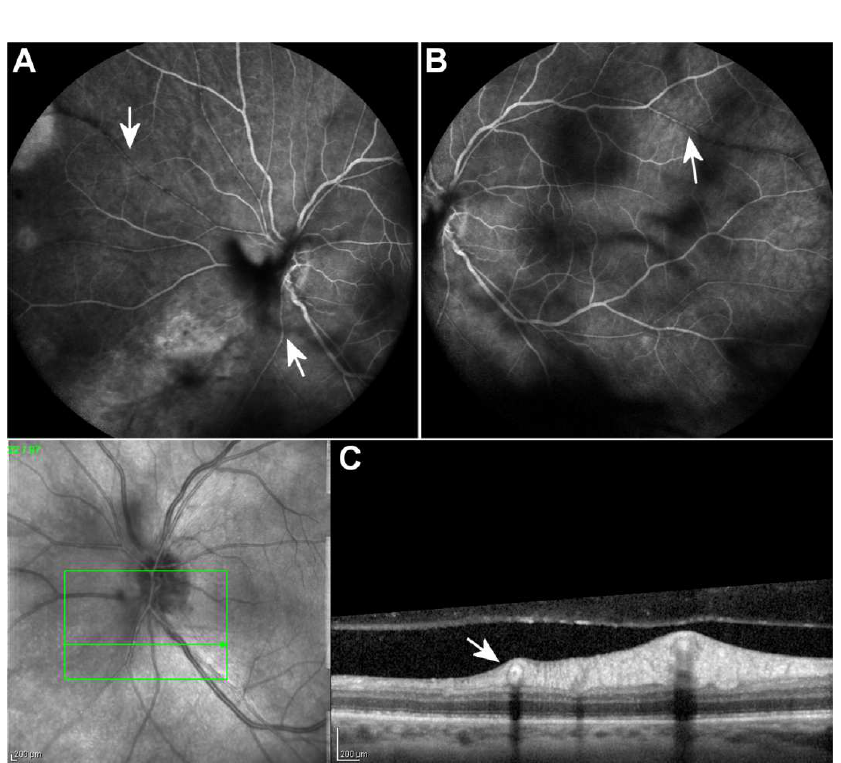
Figure 2. Fluorescein angiography 2 weeks after the initiation of treatment revealed normal arterial filling and absence of dye leakage from the Kyrieleis plaques (( A , B ), arrows). Optical coherence tomography scan along the affected vessel shows hyperreflectivity of the entire wall of the vessels (( C ), arrow). Scale bar : 200 µm